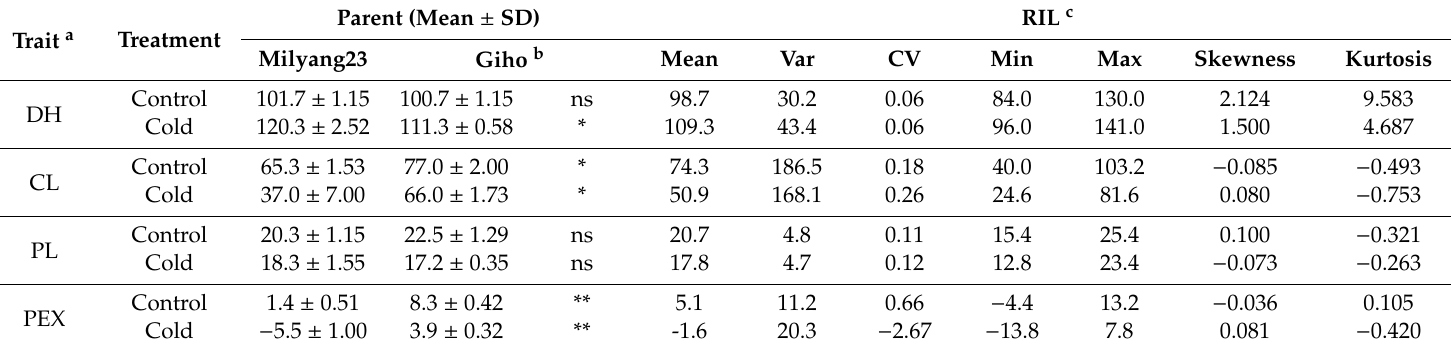
Table 2. Variation in agronomic traits in the RIL population and its parents in the control plot and the cold-water-irrigated